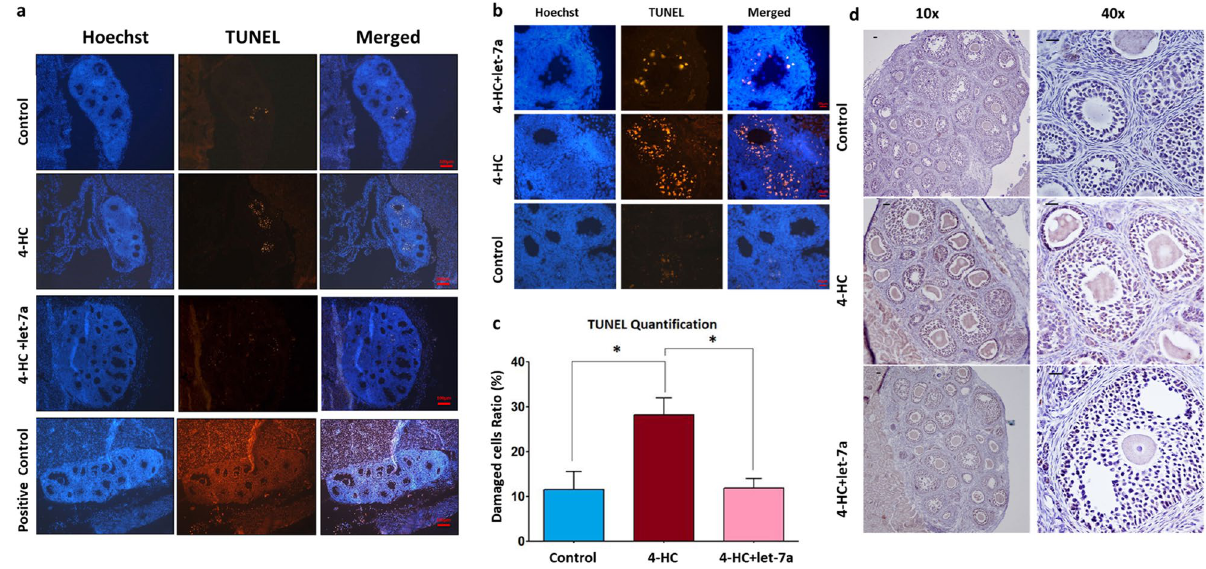
Figure 4. Evaluation of gonadotoxic damage in grafted ovaries in three different groups: control, 4-HC, and 4-HC + let-7a. ( a ) Immunofluorescent sections show nuclear labelling by Hoechst (blue) and DNA damaged/ apoptotic cells by TUNEL (red), scale bar; 100 µm and ( b ) magnified images, scale bar; 20 μm. ( c ) The quantification of damaged cells was performed in at least three different ovarian sections (N ≥ 3) for each experimental group (N = 3). The error bars represent the standard error, * p < 0.05. ( d ) Hematoxylin & Eosin counterstaining and immunostaining of FAS receptor on 5 µm sections of grafted ovaries in different conditions (N = 2). The apoptotic cells of the ovarian follicles are FAS positively stained, (10×) and magnified images (40×), scale bar; 20